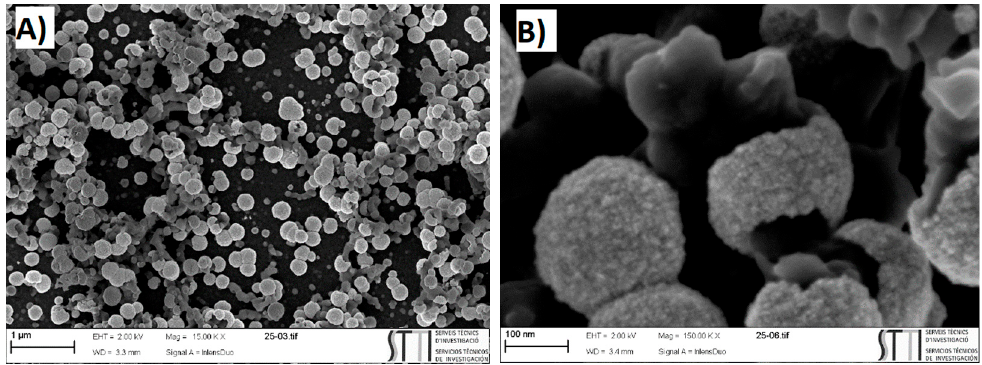
Figure 12. SEM micrographs of GC/PANI(PPP)/PtNPs using 25 s of polymerization time, with two magnifications: ( A ) 1 µ (a) and ( B ) 100 nm.